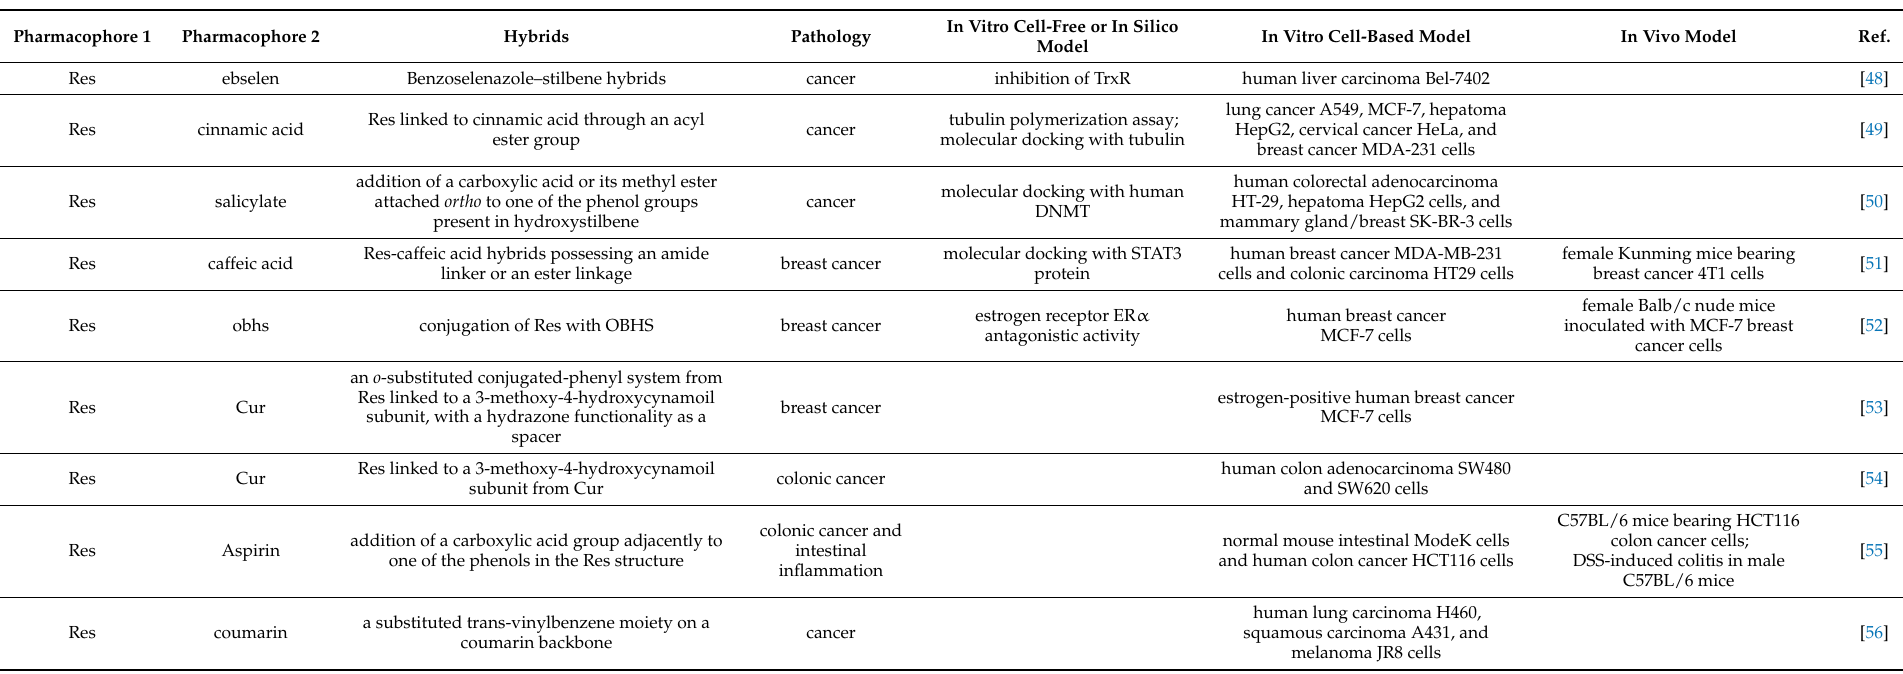
Table 1. Hybrid molecules derived from Res and designed for potential employment in human